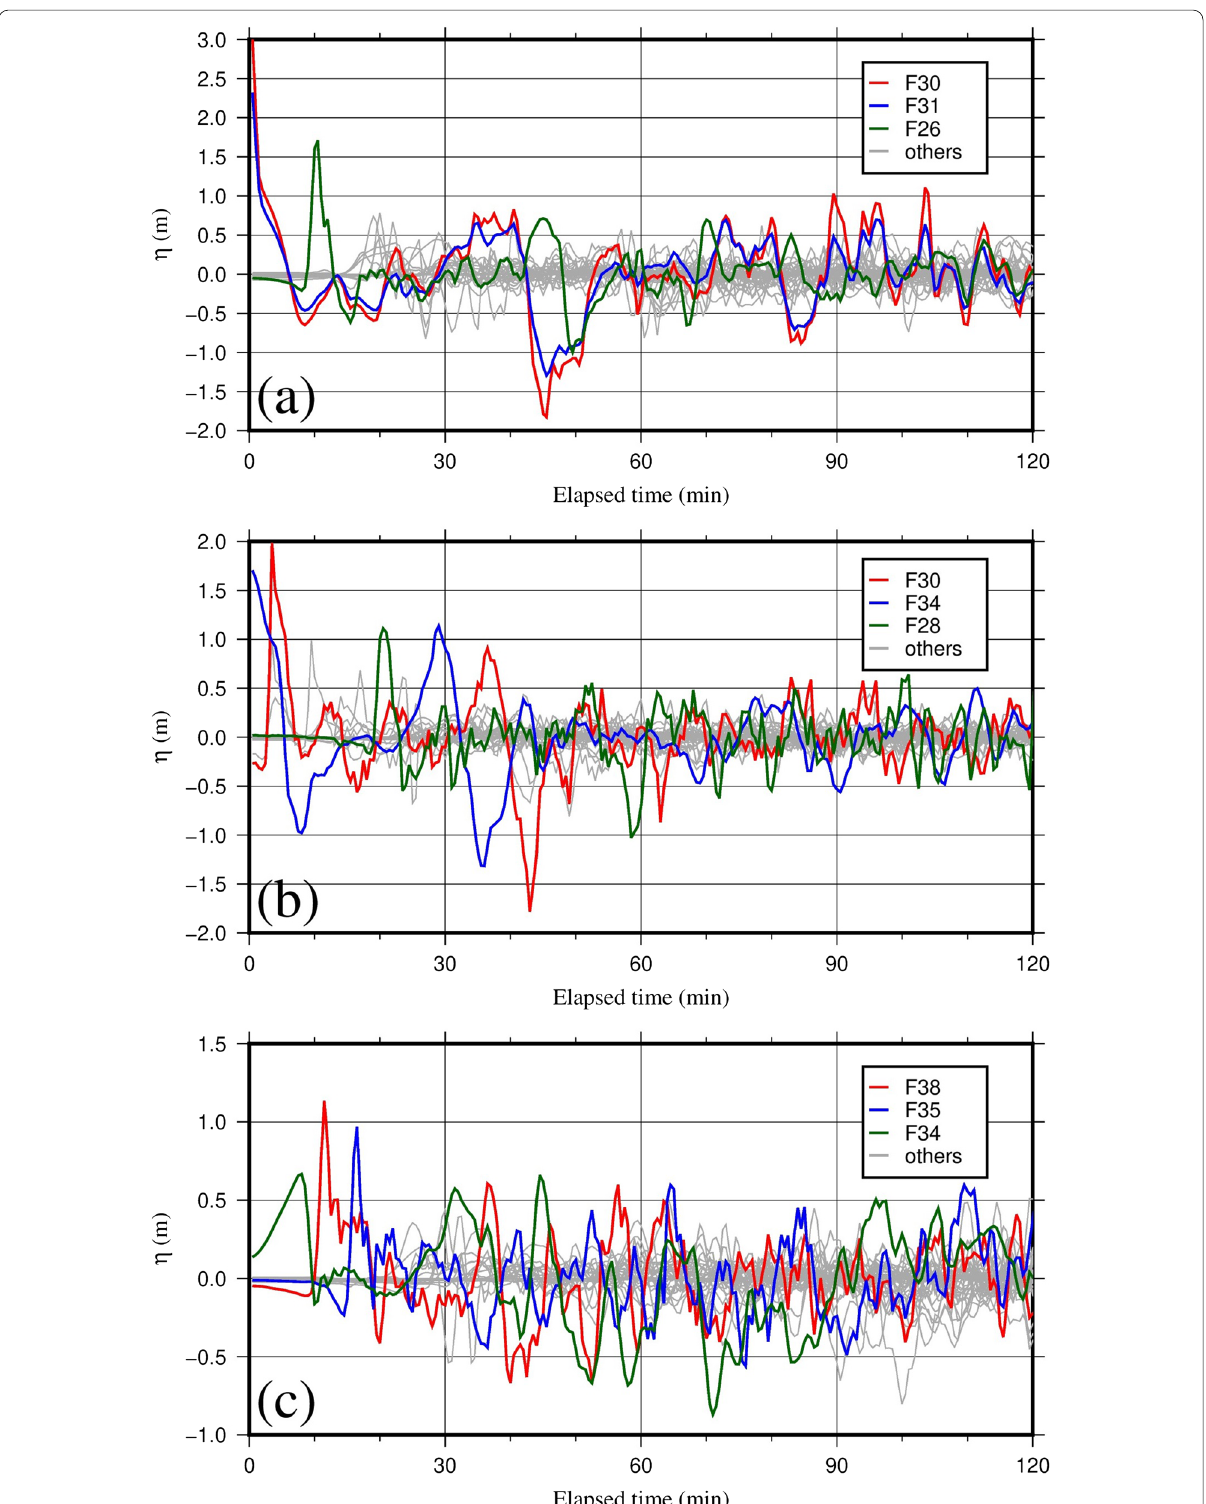
Fig. 2 Time series of water surface elevation change at locations specified by the black circles in Fig. 1b. a Off Akita; b off Sakata; c off